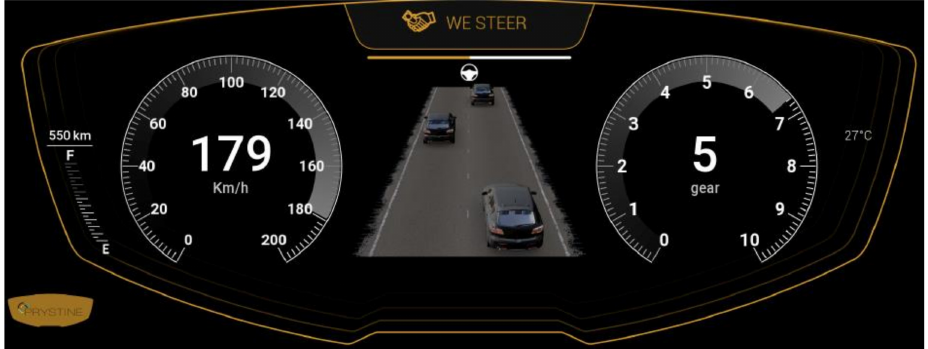
Figure 6. Example of the visual HMI, showing the level of authority and the reconstruction of the surrounding